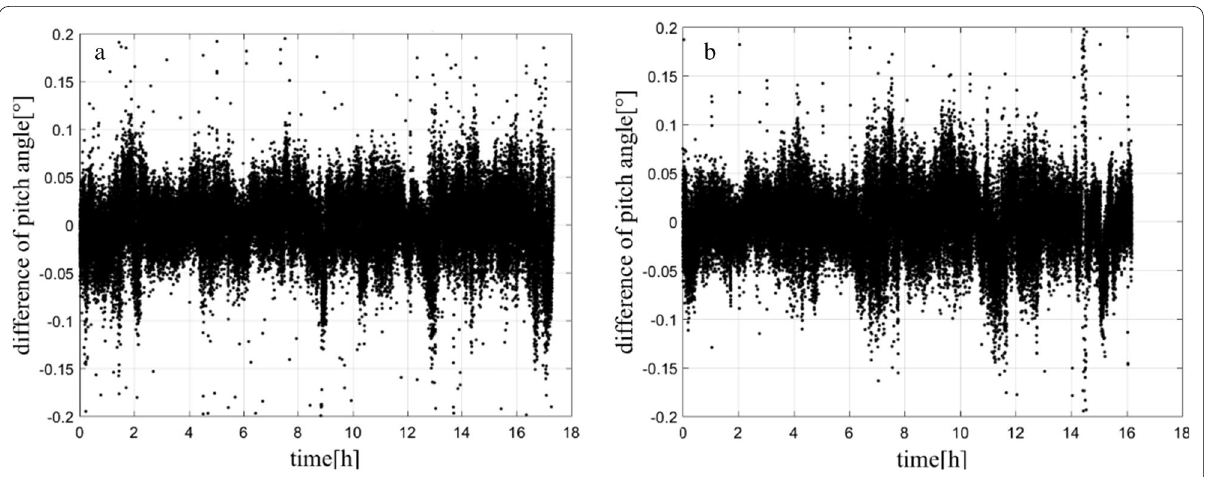
Fig. 9 Difference in the pitch angle: a for S1-2 and b for